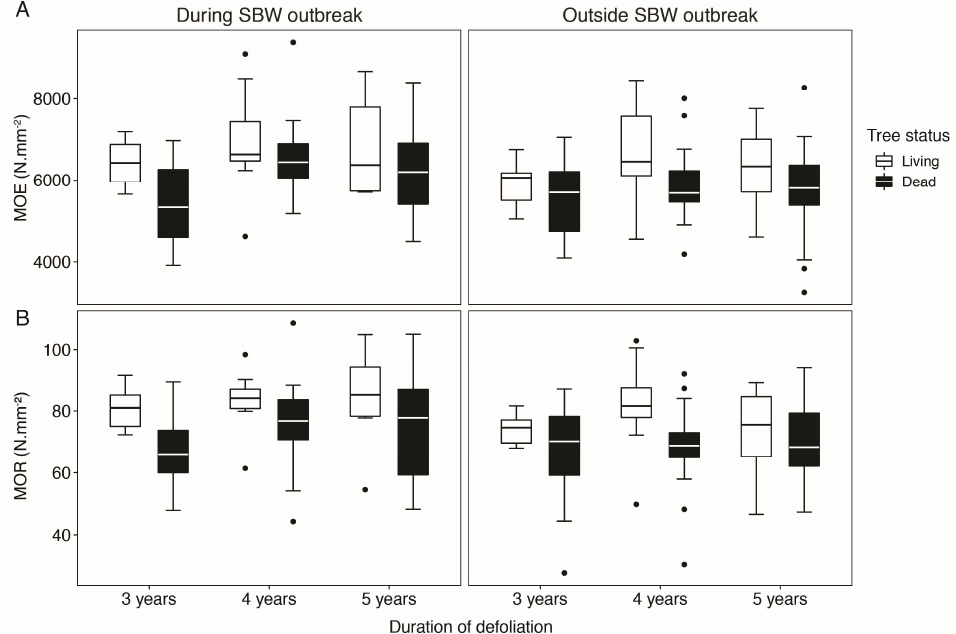
Figure 3. ( A ) Modulus of elasticity (MOE) and ( B ) modulus of rupture (MOR) of wood produced during and outside of a spruce budworm (SBW) outbreak in trees visually classified as living and dead from stands that have been defoliated for three, four or five years.